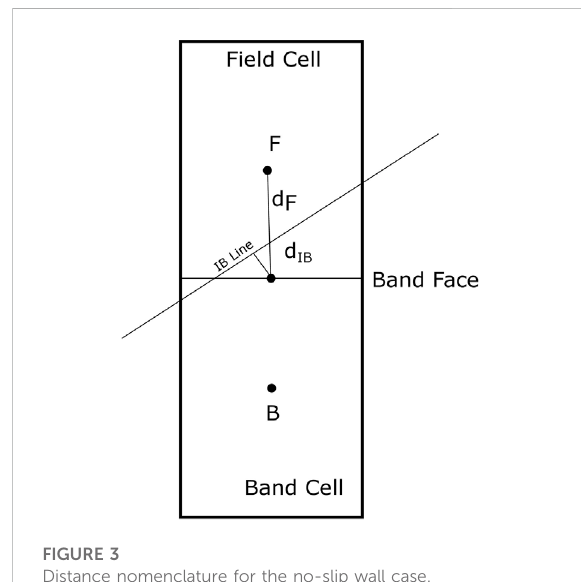
FIGURE 2 Distance nomenclature for the slip wall case.